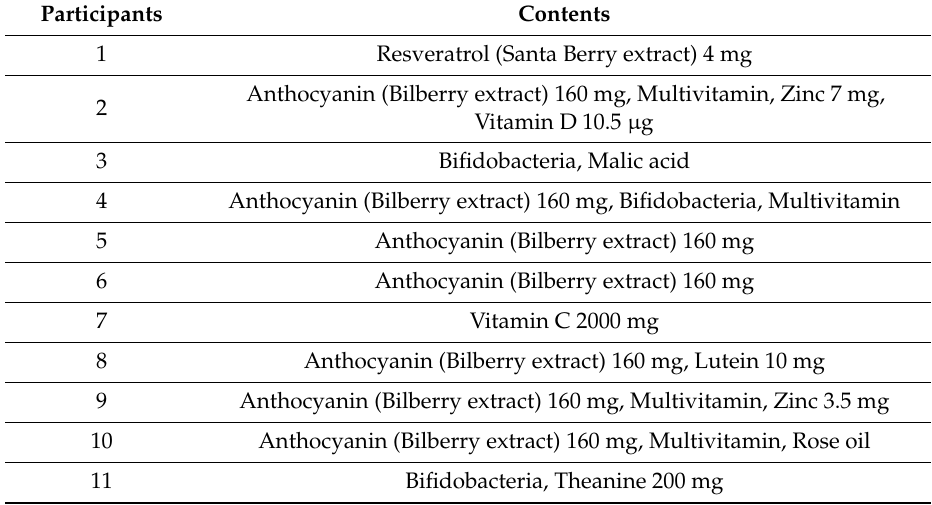
Table 2. Main contents of the antioxidative supplements taken by individuals.